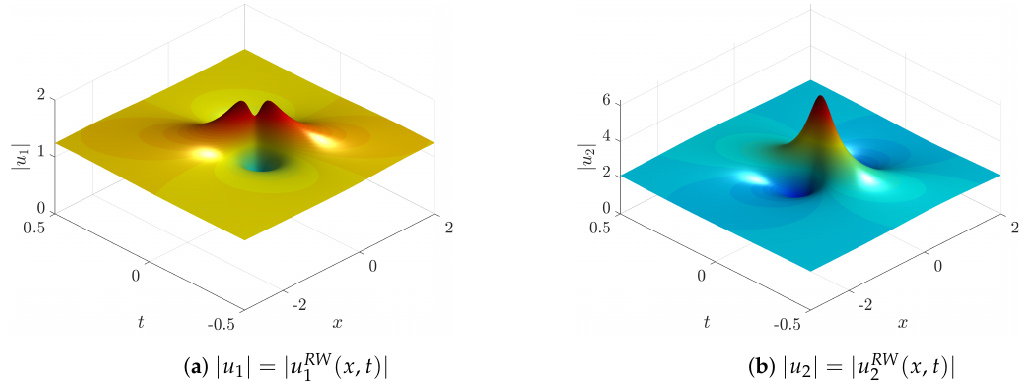
Figure 12. RW solutions corresponding to the spectrum 0 G 2 B 0 L ; branch corresponding to λ c with larger imaginary part. q = 1, s 1 = s 2 = − 1 (focussing), r = 3, p = − 6 ( a 1 = 1.2247, a 2 = 2.1213); λ c = 0.32472 + 2.3175 i , c = c 2 = 0, c 1 = 1, max | u RW